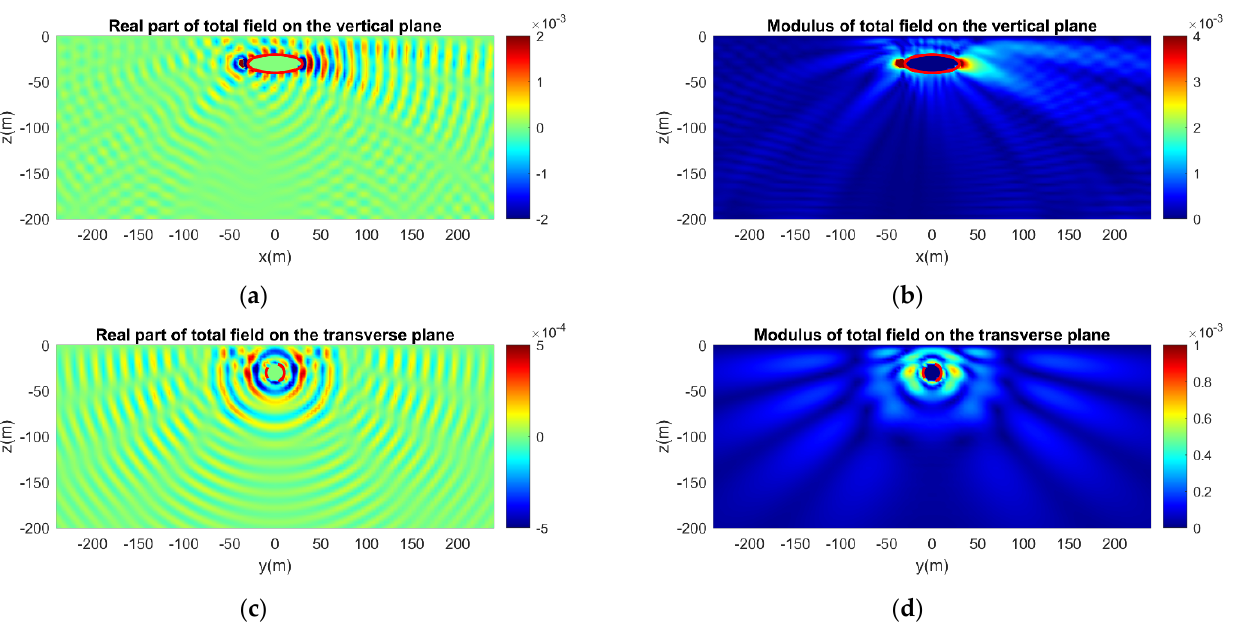
of the acoustic field on the transverse plane.